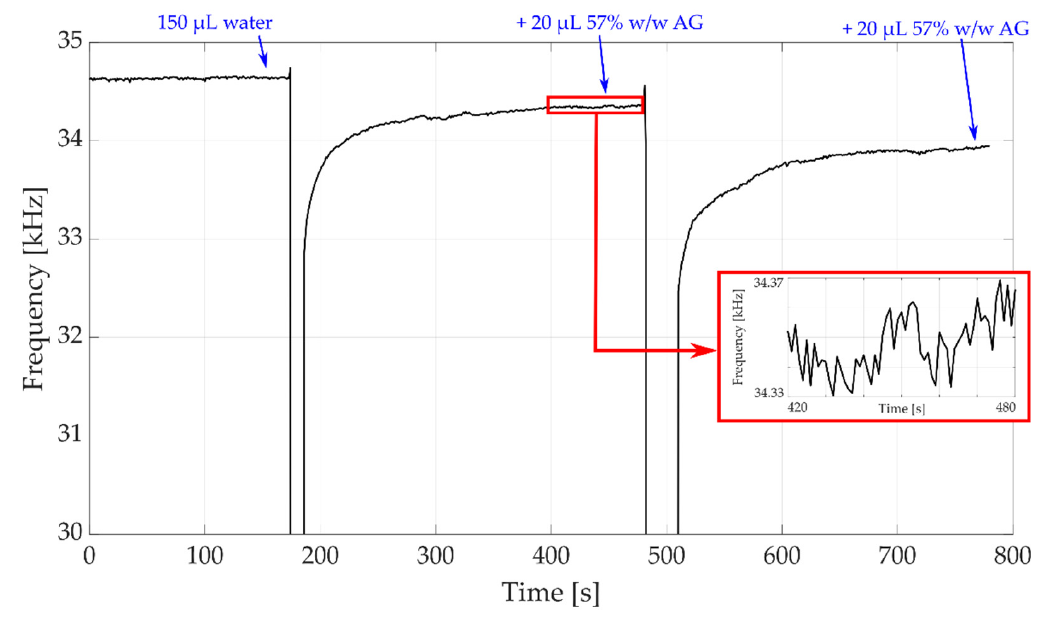
Figure 11. QCM monitoring starting from pure water (150 μ L) and adding subsequent doses of 10 µ L of a solution with 60% anhydrous glucose (AG) with a micropipette.